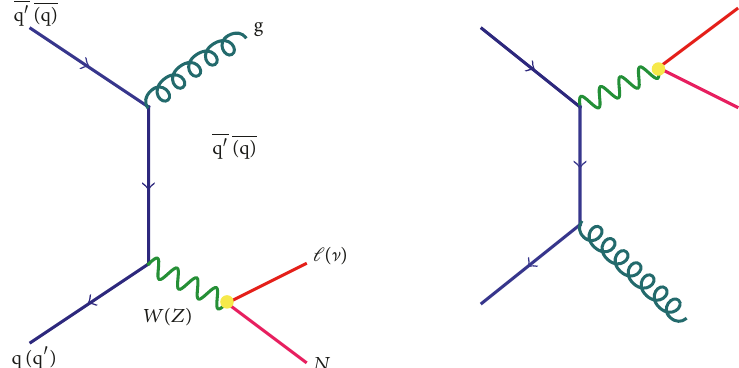
Figure 3: 1-jet process to produce 𝑁 with ℓ( ] ) in association with a jet from the CC(NC) interaction from qq 󸀠 ( qq ) initial state.